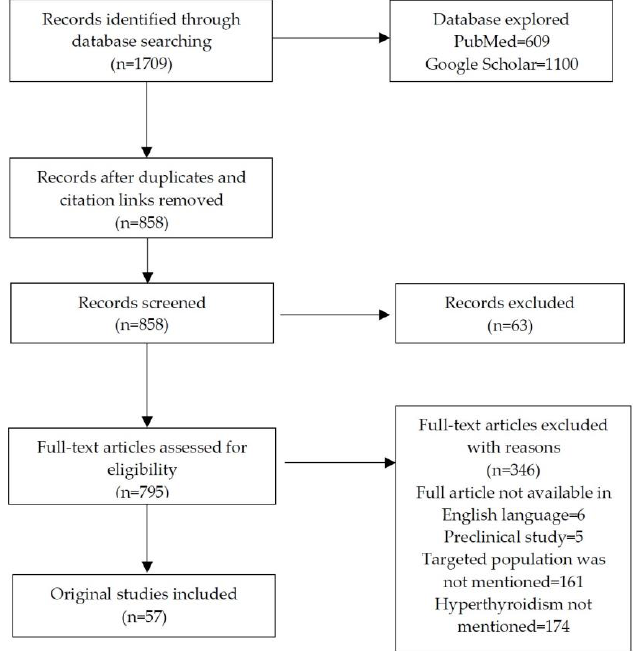
Figure 1. Literature selection and data extraction.